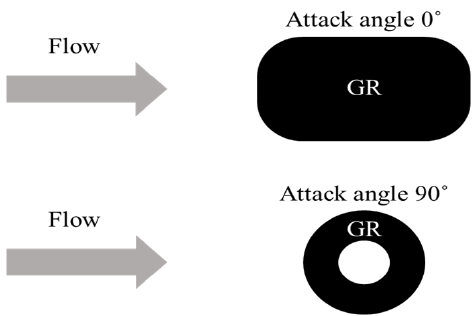
Figure 1. The definition of attack angle in floats and ground gears. Table 1. Floats and ground gears (GR) which were measured in the tank and towing experiments.